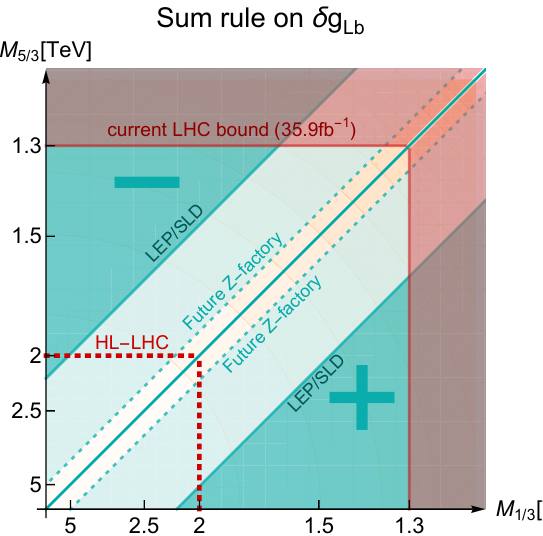
A more specific example of the schematic plot of figure 2 for the δg Lb sum rule in eq. (5.11) with realistic bounds from current and future experiments (all at 95% CL). Note that the axes are scaled linearly with 1 /M 2 . The diagonal line corresponds to δg Lb = 0 , while the plus (minus) sign denotes the region in which δg Lb is positive (negative). The relevant Yukawa couplings (as in eq. (5.9)) are assumed to be one for